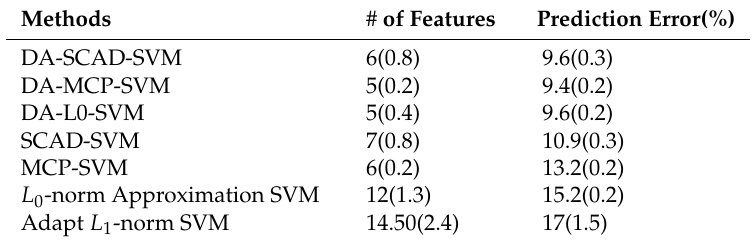
Table 3. Classification outcome on the Wisconsin Breast Cancer data set. Margins are provided in